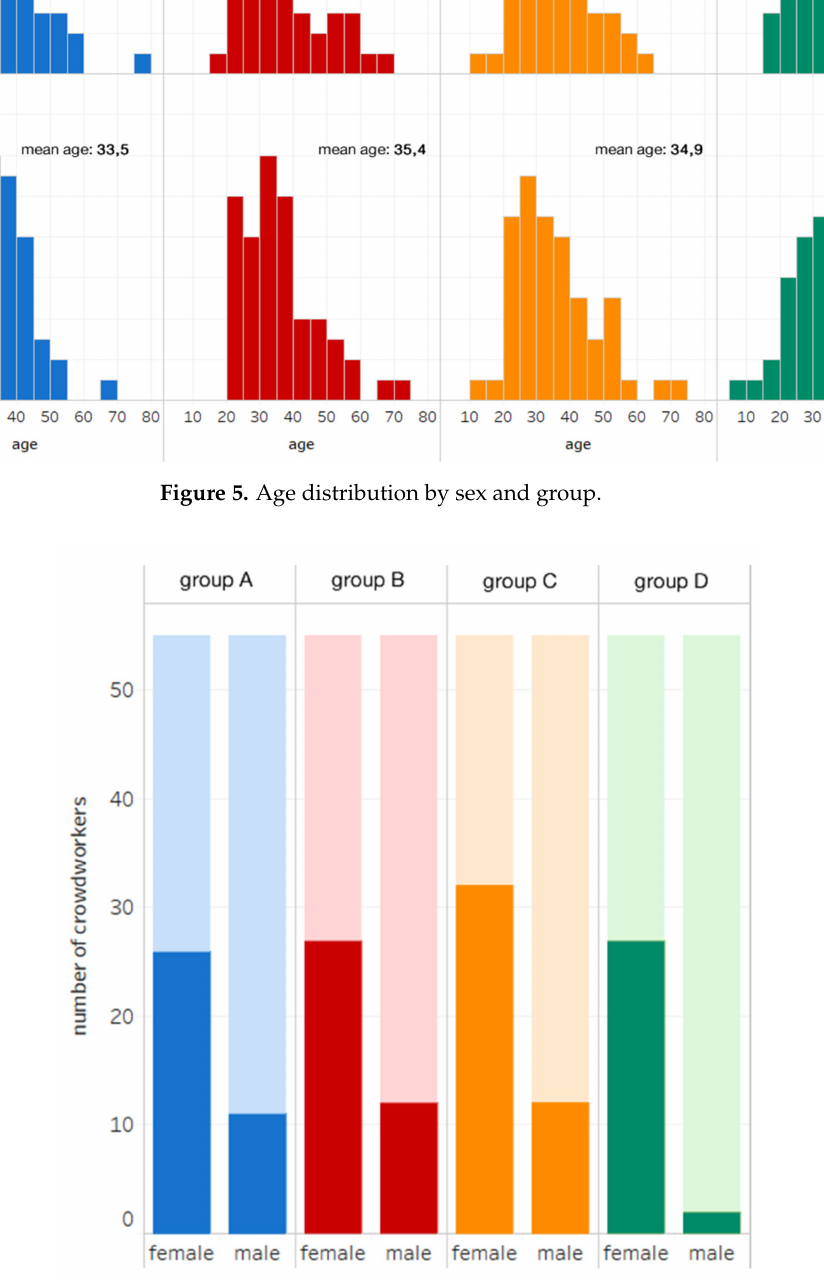
Figure 6. Saturated bars show the number of crowdworker responses (33.4% of total) by sex and group. Compare to the proportion of other participants, depicted by the light